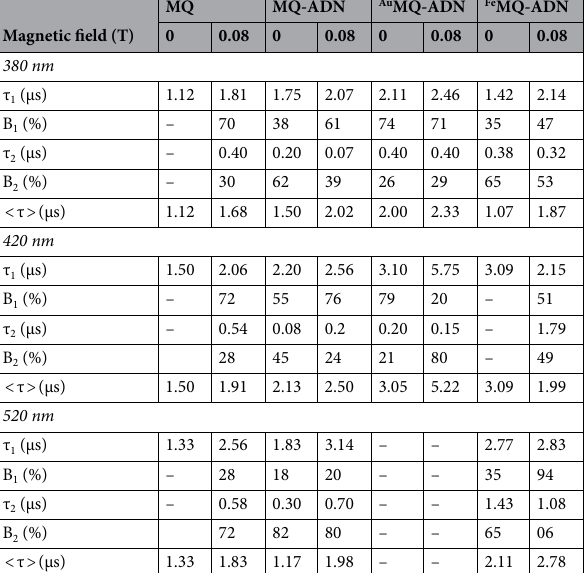
Table 1. The lifetime of transient species (τ) obtained at their respective wavelengths has been calculated in the presence and absence of a 0.08 T MF. The parenthesis represents the amplitude of the transients obtained from the fitting (Eq. 2). The experimental error in the above measurements is less than